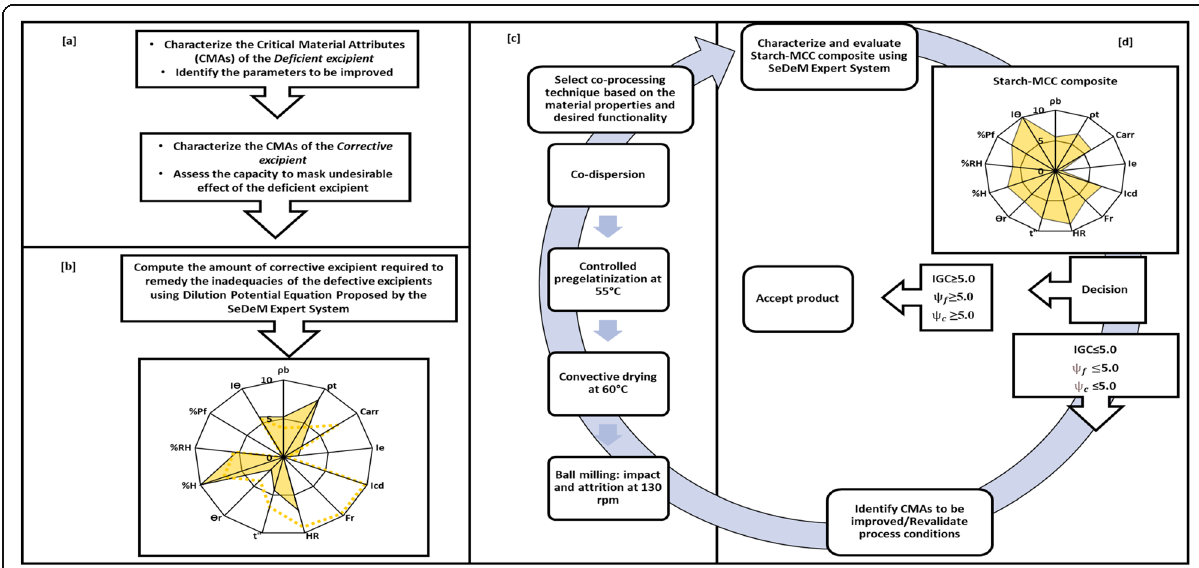
Fig. 4 Application of SeDeM Expert System in particle engineering design space of co-processed excipients. Stage I involves the characterization of Critical Material Attributes (CMAs) of both defective and corrective materials using SeDeM methodology [ a ]. Stage II: Computing the loading capacity of the corrective excipient using dilution potential equation proposed by the SeDeM Expert System [ b ]. Stage III: Selection of co- processing technique based on intrinsic material property and desired CMAs [ c ]. Stage IV: Evaluating the impact of co-processing by monitoring the critical behavior of the engineered composite with the decision on either to accept or reject the product [ d ]. Upon failing to meet up with the critical specifications or acceptance criteria, the process conditions in Stage III can be revalidated or modified. IPP: Parametric Profile